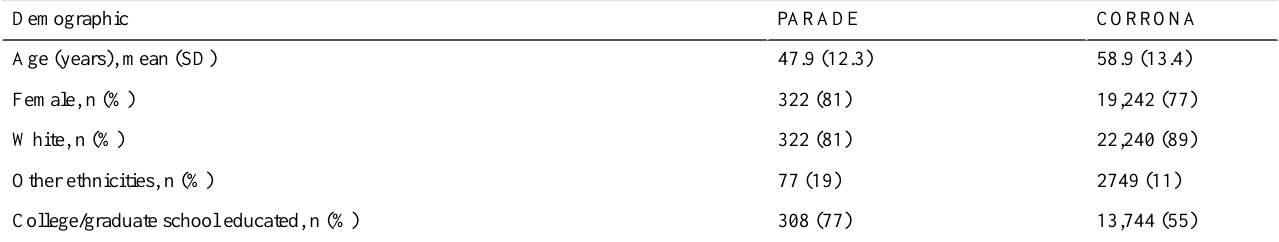
Table 3. Demographic profile of Patient Rheumatoid Arthritis Data From the Real World (PARADE) participants compared with representative data from the Consortium of Rheumatology Researchers of North America (CORRONA) registry of US patients with rheumatoid arthritis [25].